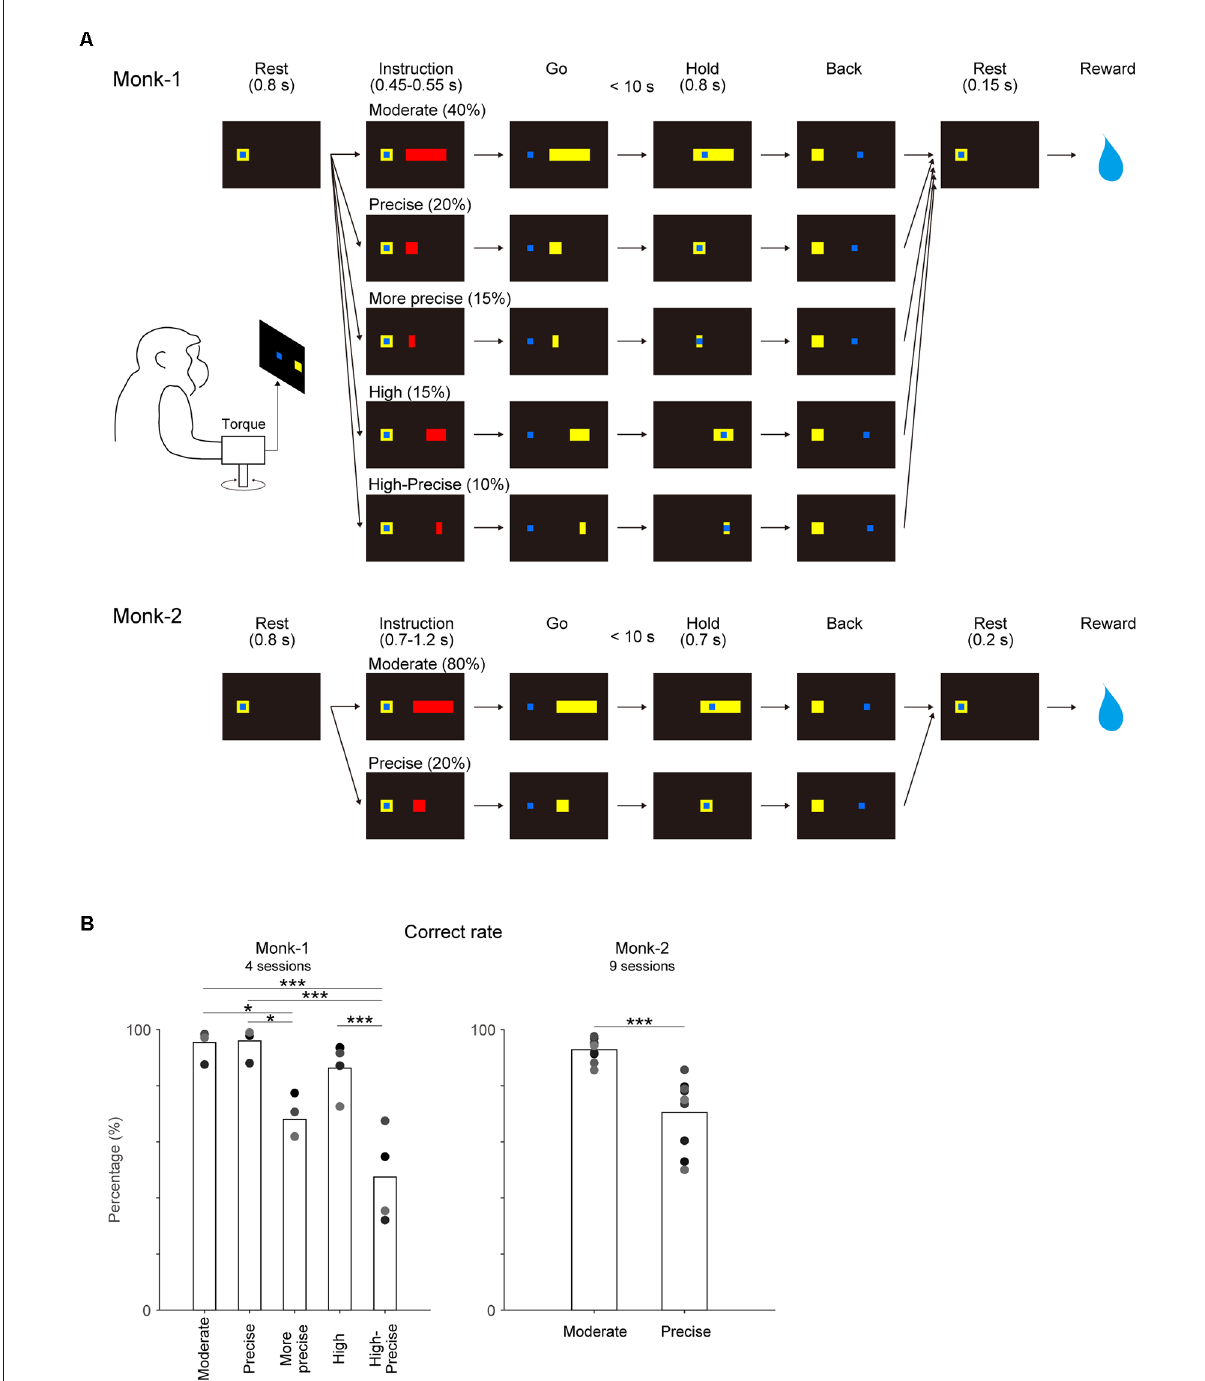
FIGURE1 Behavioral task and its performance. (A) Each monkey controlled the position of the cursor (blue square) using wrist torque to acquire targets (yellow) displayed on the screen. After target instruction (red) for a preset time, the target color changed from red to yellow (go cue). Moderate target accepted the wide range of torque output by auxotonic torque production (Monk-1) or isometric torque production (Monk-2) about the wrist joint. Precise target required precise control of torque output. Additional three targets were imposed for Monk-1 as follows: More precise target required more precise control, High target required high torque output, and High-Precise target required precise control of high torque output. The probability of each target appearance is shown. (B) Correct rate for each target. Individual gray dots indicate the results of each session. One-way factorial ANOVA and post hoc comparison with Bonferroni correction for Monk-1, and paired t -test for Monk-2 were conducted. * P < 0.05, *** P <